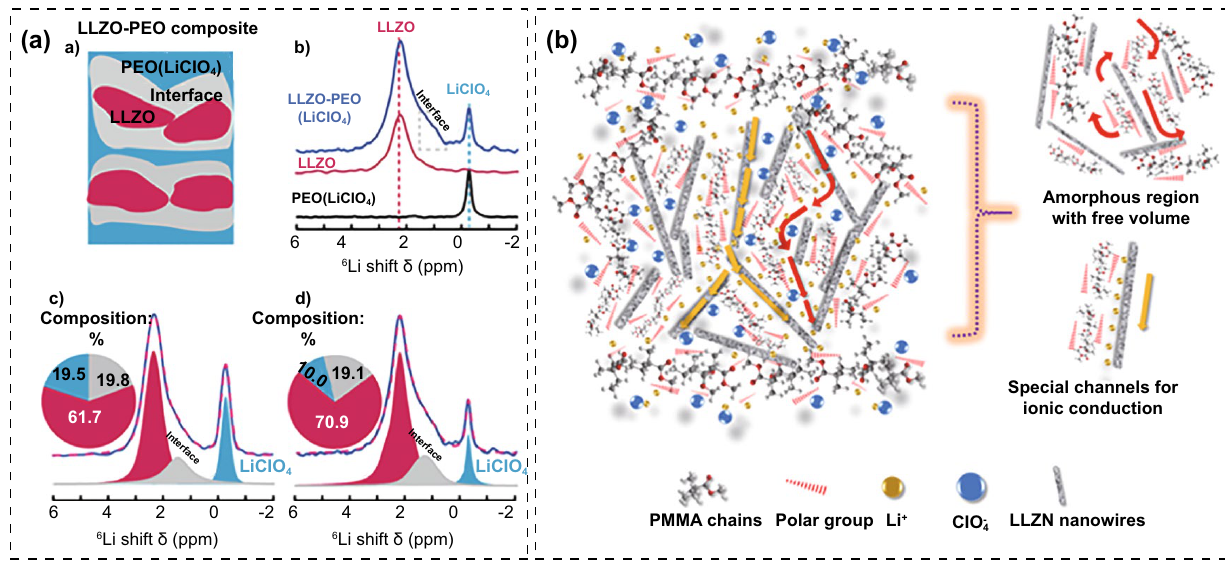
Fig. 10 a NMR spectra and spectral simulation for LLZO, PEO-LiClO 4 and PEO-LiClO 4 @LLZO [176]. Copyright 2019, John Wiley and Sons. b Multiple Li + conduction forms in PMMA-LiClO 4 @LLZN [165]. Copyright 2019,